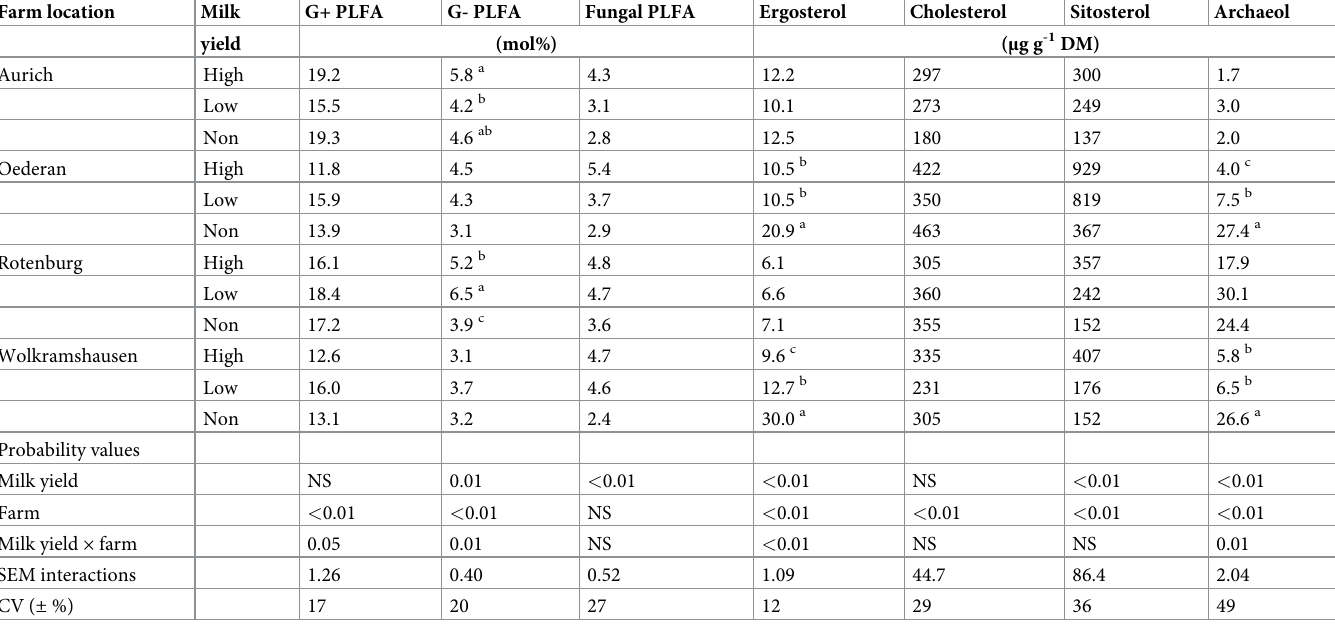
Table 4. Mean contribution of indicator phospholipid fatty acids (PLFA) for Gram-positive (G+) bacteria (15:0i, 15:0a, 16:0i, 17:0i, 17:0a), Gram-negative (G-) bac- teria (cy17:0, 16:1 ω 9c), and fungi (18:2 ω 6,9) to total PLFA in the cow faeces, as well as the contents of ergosterol, cholesterol, sitosterol, and archaeol in the cow fae- ces, broken down according to the four farms and the three milk yield